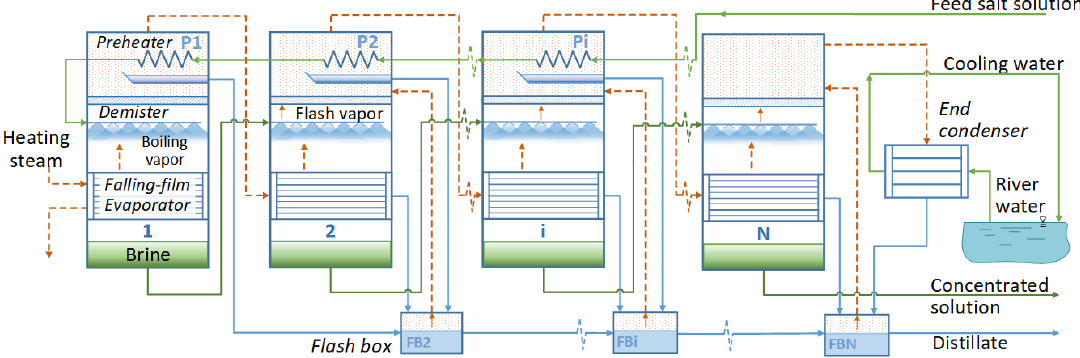
Figure 5. Scheme of the Forward-Feed Multi-Effect Distillation (MED) regeneration plant.